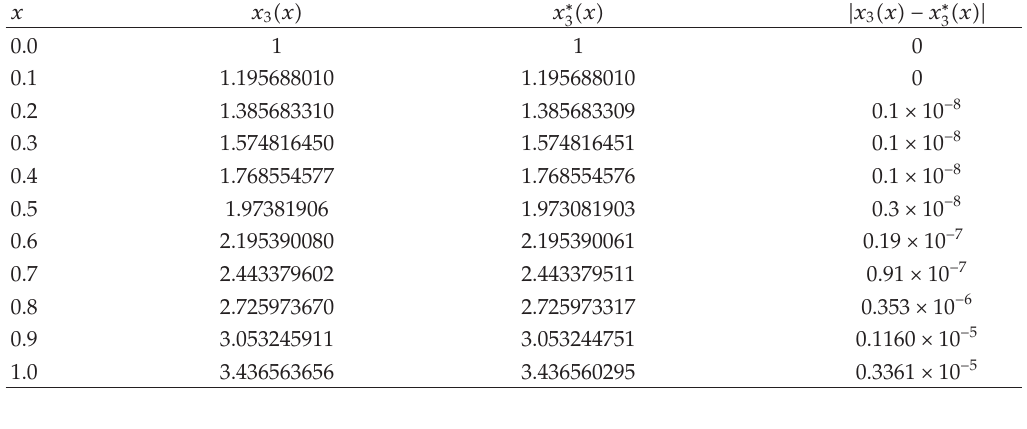
Table 3: Numerical solution of x 3 (cid:3) x (cid:4) .